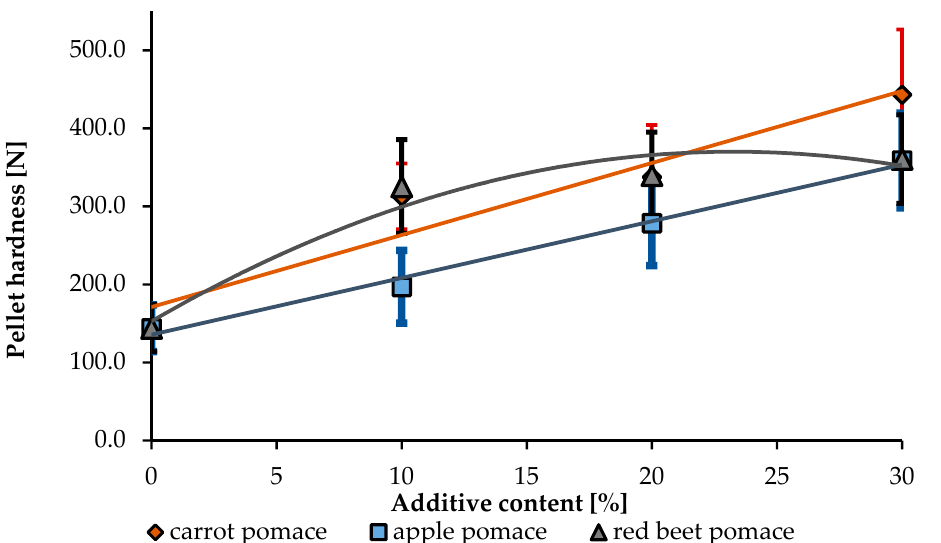
Figure 6. Effect of the additive contribution in the mix with barley straw on the hardness of pro- duced pellet.